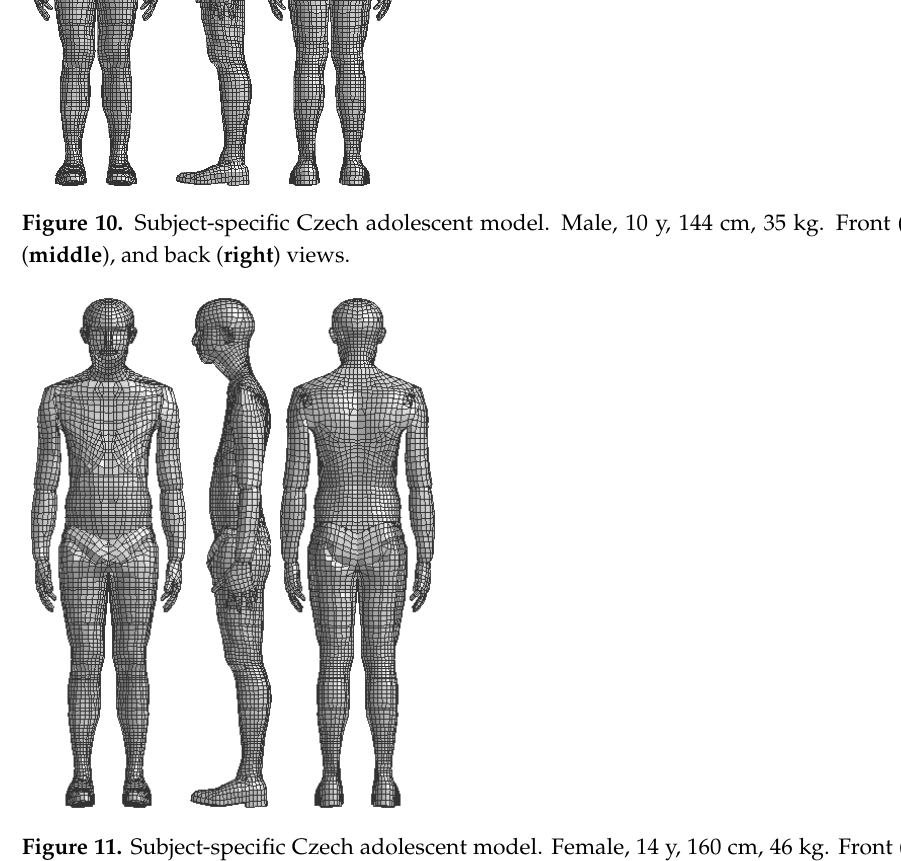
Figure 11. Subject-specific Czech adolescent model. Female, 14 y, 160 cm, 46 kg. Front ( left ), side ( middle ), and back ( right )